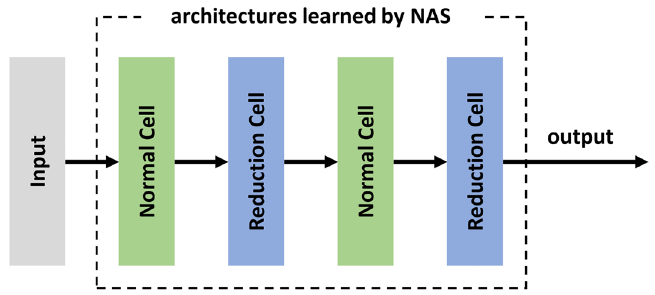
Figure 14. CNN structure with four cells for RUL